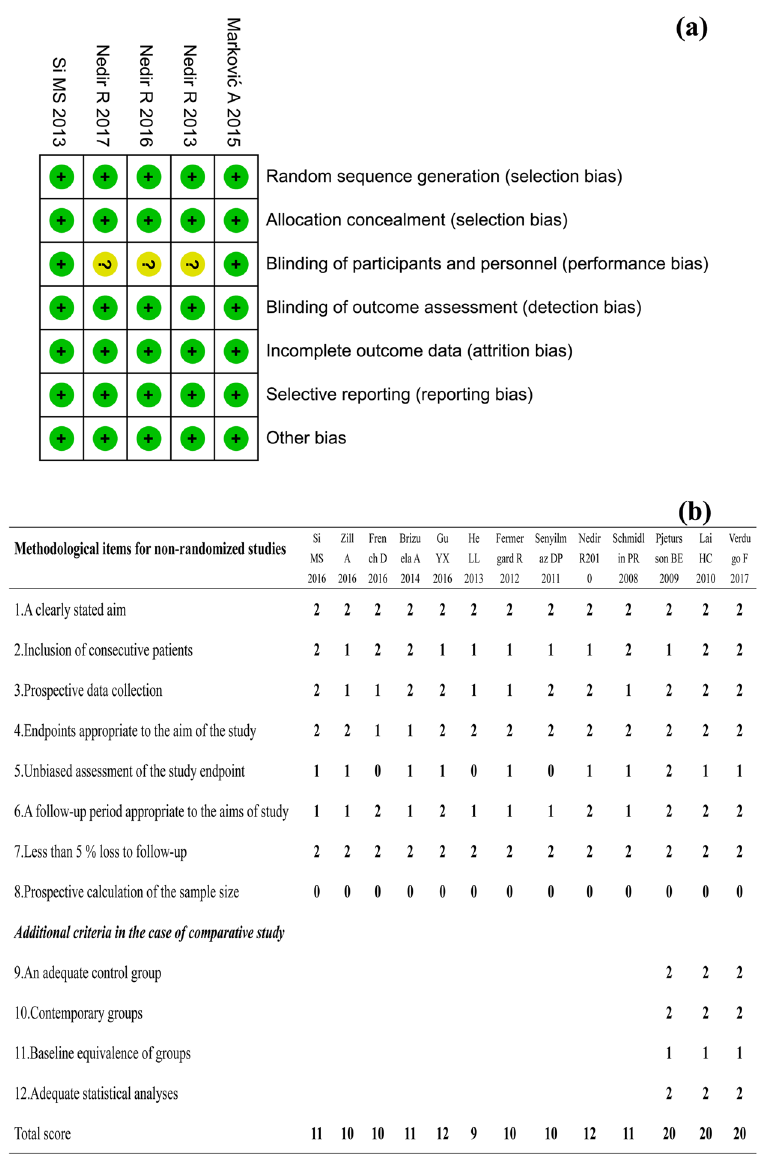
Figure 2. Quality assessment of included studies. ( a ) Risk of bias summary for randomized studies (“ + ” means low risk of bias, “?” means that the risk of bias is unclear, “ − ” means that the risk of bias is high). ( b ) Quality assessment for non-randomized studies by MINORS 31